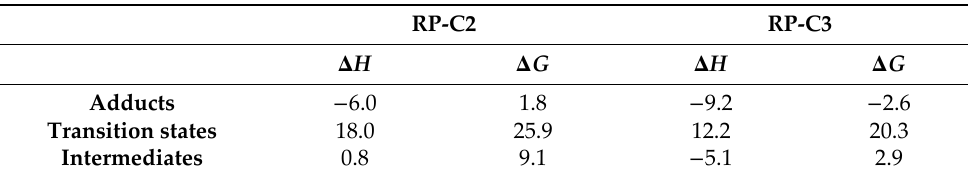
Table 4. Changes in the thermodynamic properties associated with the stationary points along RP-C2 and RP-C3. All values are given in kcal mol − 1 .